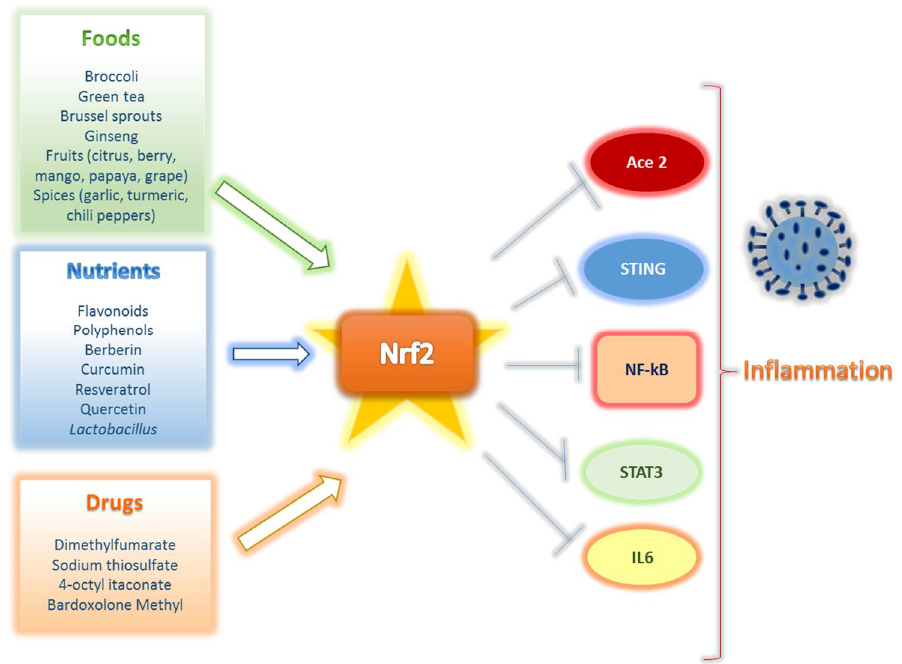
Figure 6. The potential of Nrf2 activators in combating COVID-19. Foods containing antioxidants that stimulate Nrf2, such as vegetables; specific natural compounds; synthetic drugs or metabolites can produce Nrf2 activation thus targeting those factors that are involved in SARS-CoV-2-induced inflammation and consequent cytokine storm.